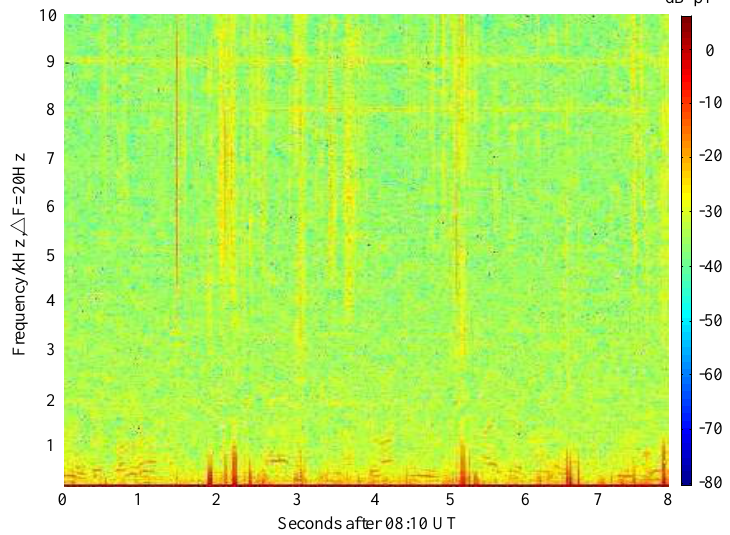
Figure 7. Spectrogram of the atmospheric noise lower than 10